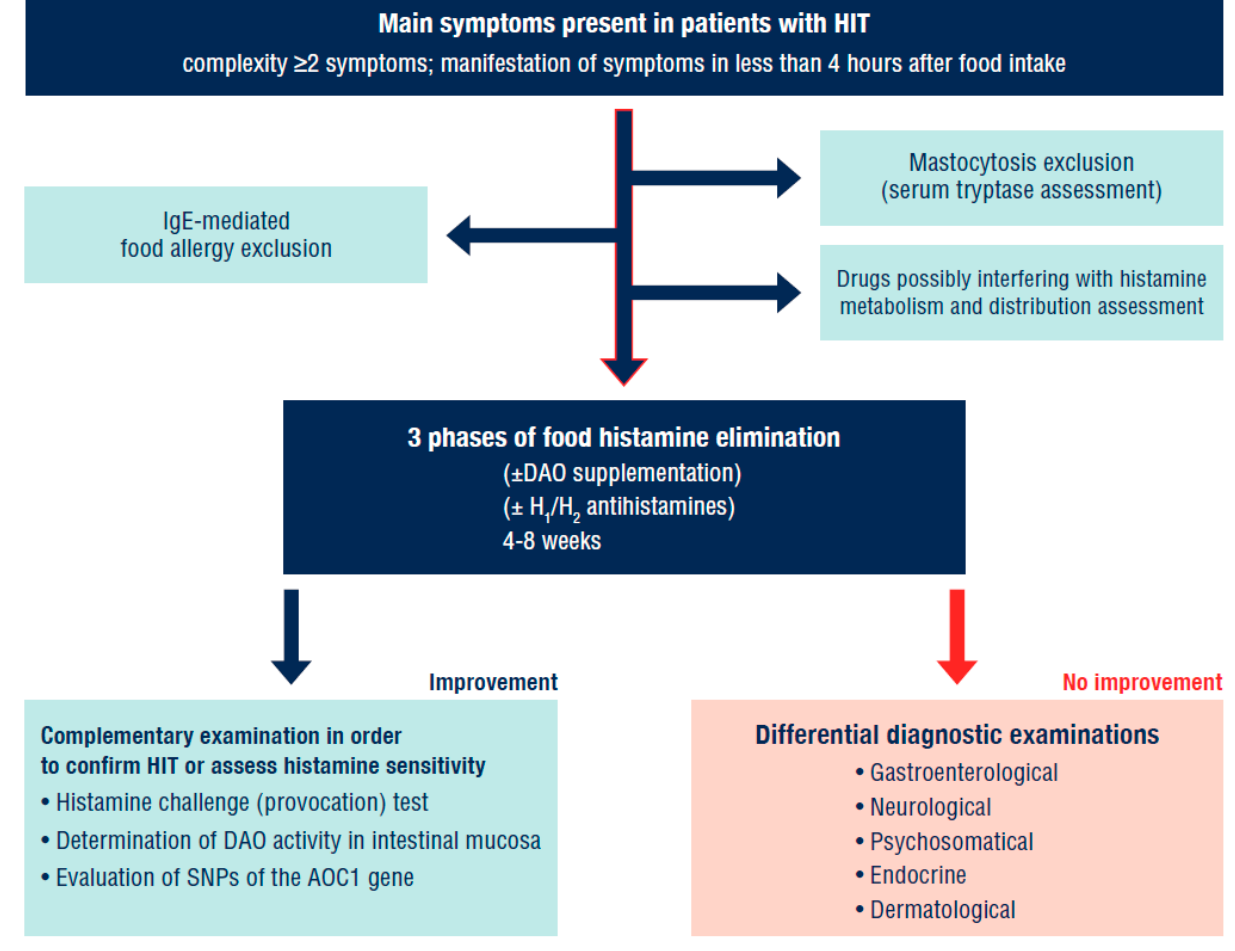
Figure 5. Diagnostic approach in a patient with suspected HIT. IgE—immunoglobulin E; DAO—diamine oxidase; HIT— histamine intolerance; SNPs—single nucleotide polymorphisms; AOC1—amine oxidase copper containing 1. Adapted according to [1,6,9].